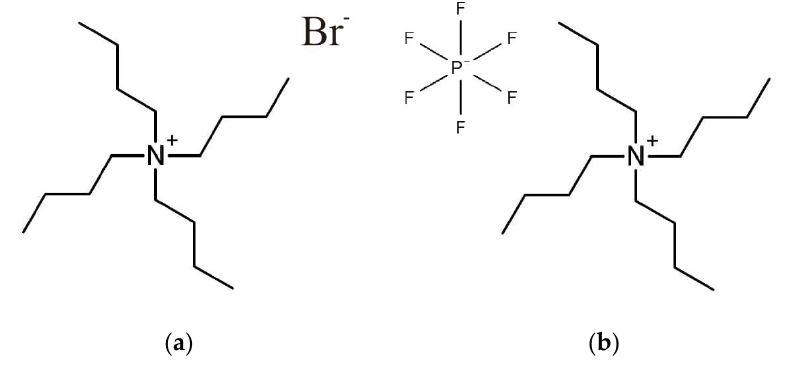
Figure 1. Structure of ( a ) TBA-Br and ( b ) TBA-PF 6 .